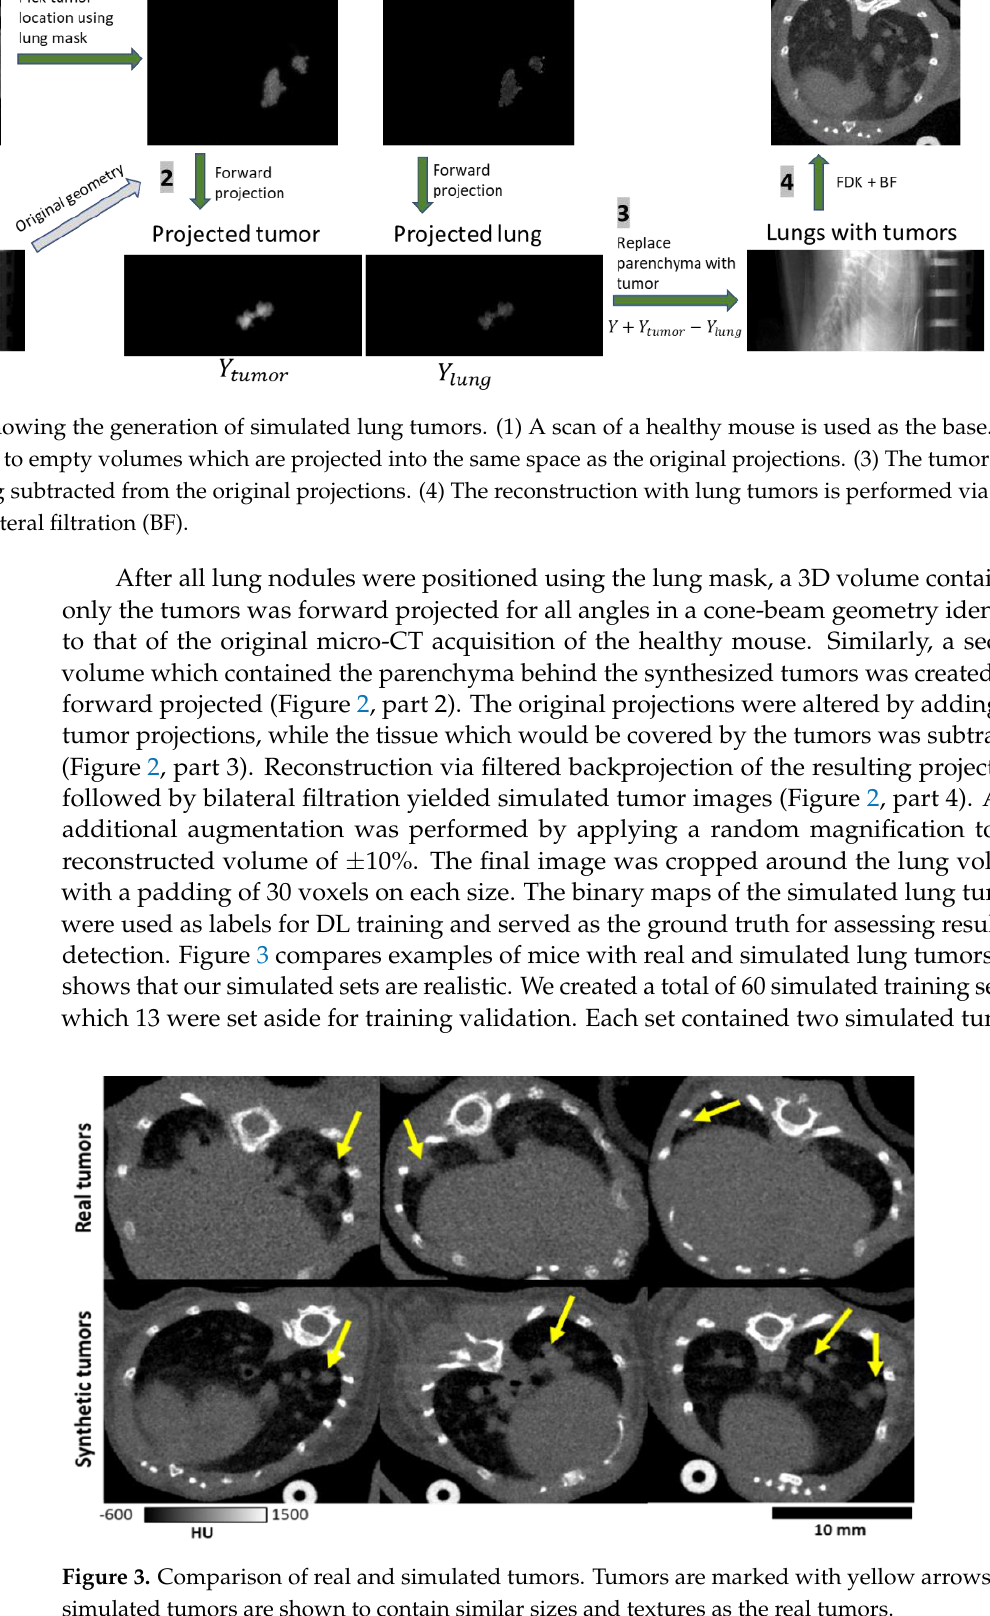
Figure 3. Comparison of real and simulated tumors. Tumors are marked with yellow arrows. The simulated tumors are shown to contain similar sizes and textures as the real tumors.